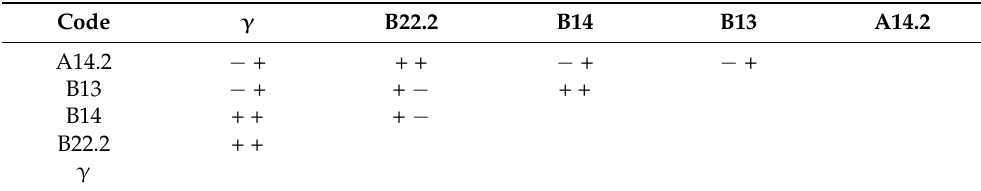
Table 5. Matrix of inhibition and growth results of the 10 combinations of microorganisms in a Petri